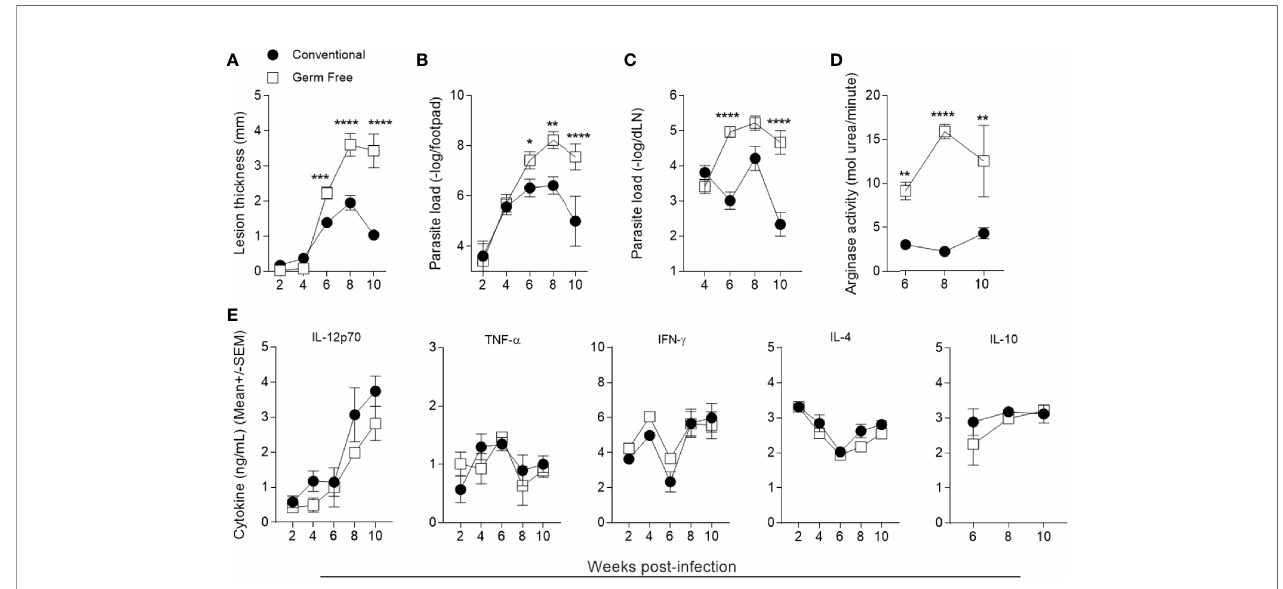
FIGURE 1 | Germ-free mice polarize immune response to Th1 but are still susceptible to L. major infection. (A) Lesion thickness in footpads was monitored every two weeks up to 10 weeks post infection. (B) Quanti fi cation of parasite loads in footpads by limiting dilution analysis. (C) Quanti fi cation of parasite loads in popliteal draining lymph nodes by limiting dilution analysis. (D) Arginase activity in footpads 6, 8 and 10 weeks after infection. (E) Cytokine production by popliteal lymph node cell culture supernatants 2, 4, 6, 8 and 10 weeks after infection 72h (IFN- g , IL-12p70, IL-4 and IL-10) and 24h (TNF) after stimulation with L. major antigens. *, **, ***, **** indicates statistical difference between the two groups at the same time point using two-way ANOVA and post-Bonferroni test (p < 0.05; p < 0.01; p < 0.001; p < 0.0001). Results are representative of three independent experiments. Three to5 animals were used per group in each time